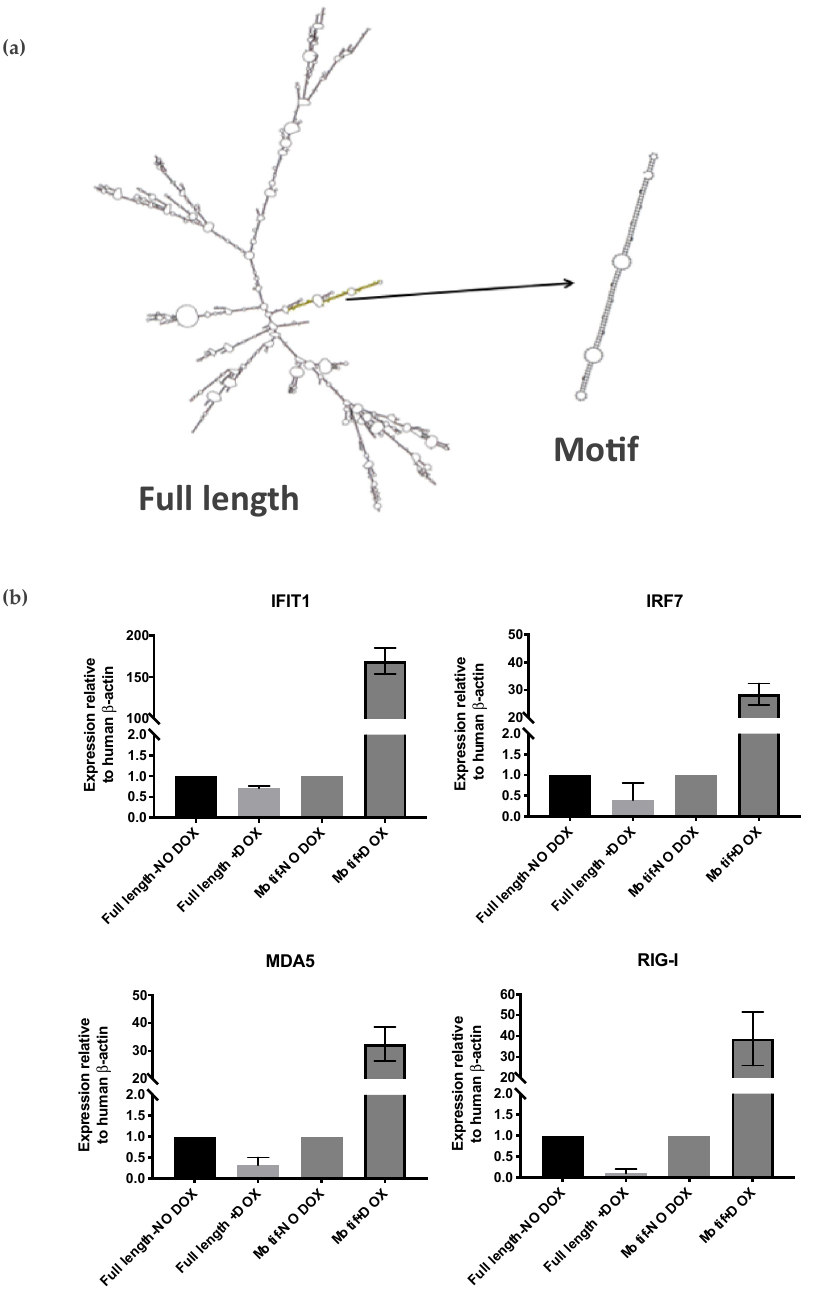
Figure 5. VL30 contains a long dsRNA motif whose overexpression induces interferon-stimulated gene expression. ( a ) Secondary structures of full length VL30 (left) and Motif only (right) generated by MFold. The VL30 motif forms a dsRNA-like structure. ( b ) Relative expression of IFIT1, IRF7, MDA5 and RIG-I in SH-SY5Y cells transduced with full length VL30 and motif only constructs in the presence or absence of doxycycline. Data represent technical triplicates and error bars represent